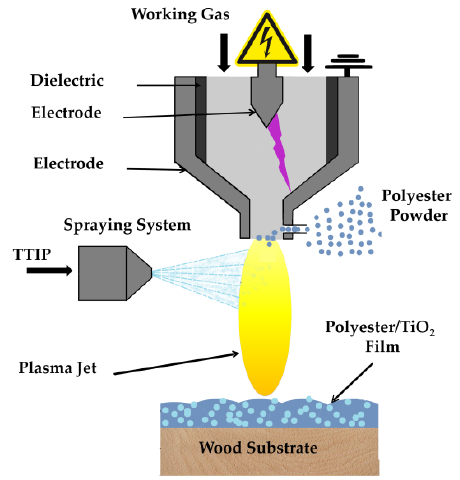
Figure 1. Scheme of the experimental setup for the deposition of polyester/TiO 2 films on wood substrate.